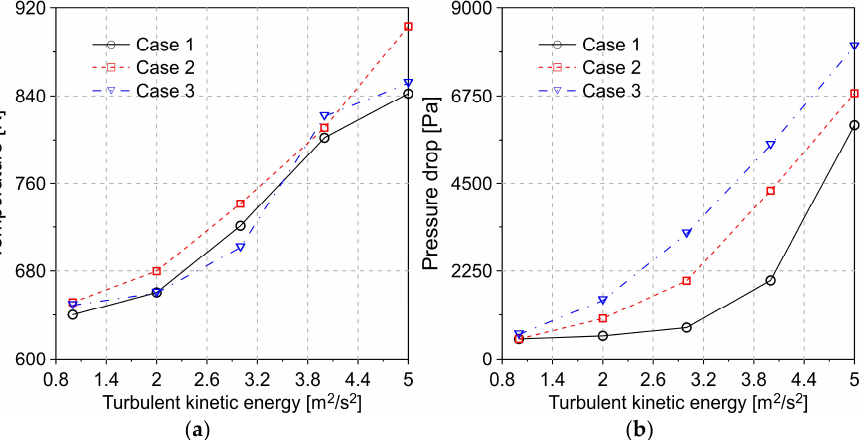
Figure 23. Thermodynamic performance of the modified zig-zag channel under critical conditions: ( a ) flow temperature; ( b ) pressure drop.